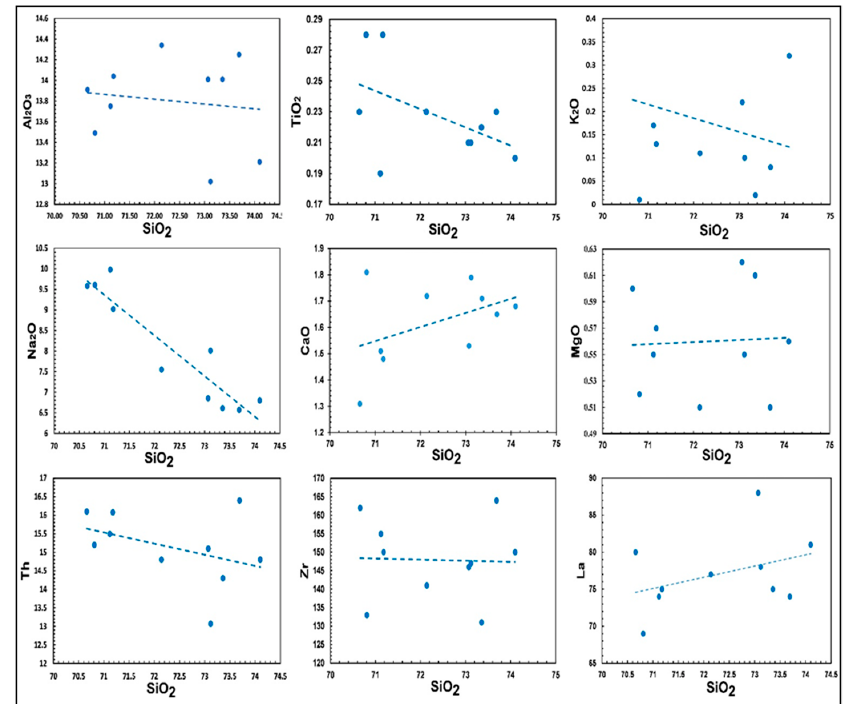
Figure 5. Harker variation diagrams of Abu-Dabbab plagio-granites.